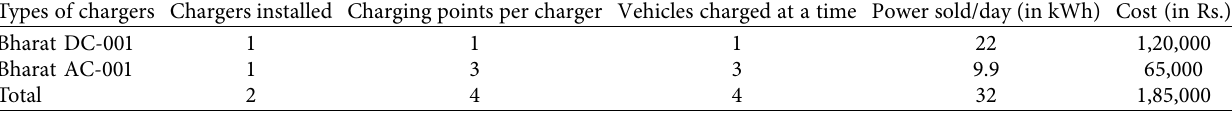
Table 12: Slow solar powered charging station